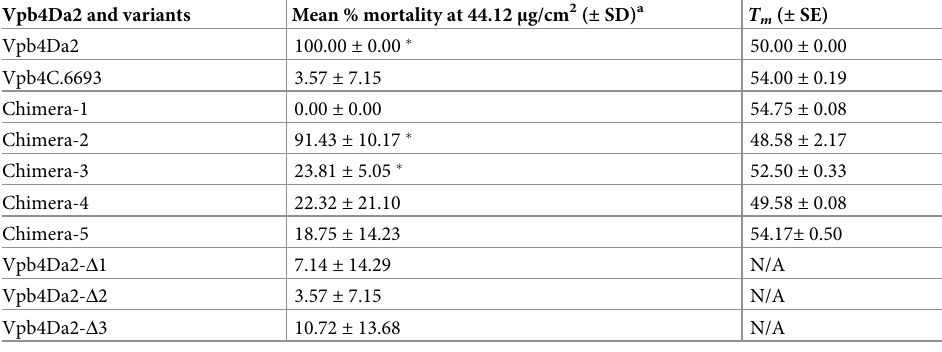
Table 1. Insecticidal activity of Vpb4Da2, Vpb4C.6693, and corresponding chimeras and deletions. Vpb4Da2 and